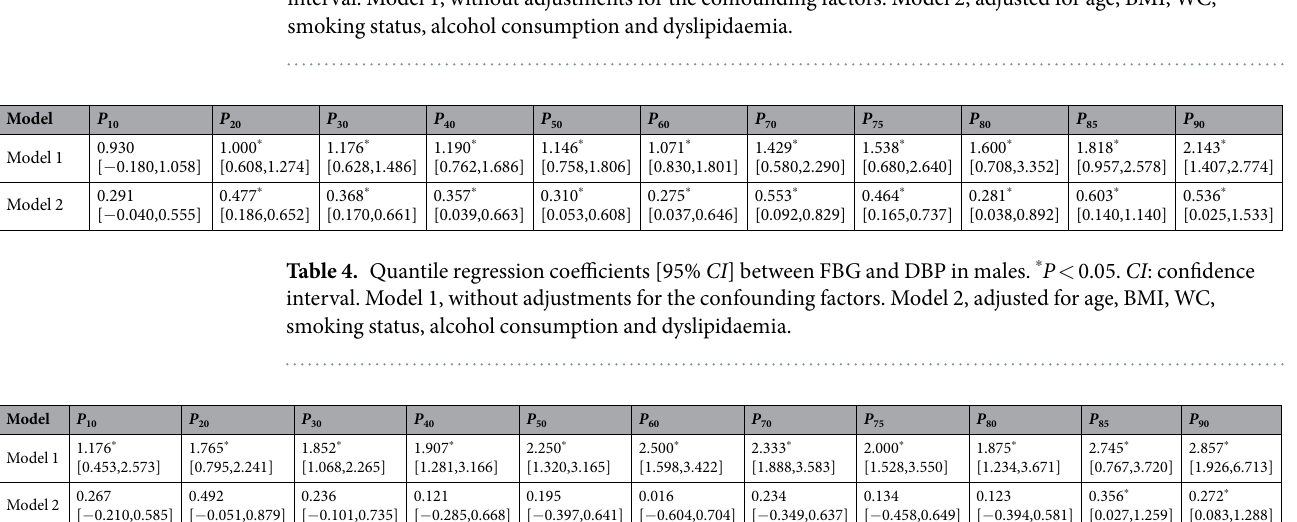
In addition, we found that the associations of BP with FBG were different in males and females; FBG was positively associated with both SBP and DBP in almost all quantiles in males, whereas FBG had positive associa- tions with only SBP in the high quantiles in females. The finding implied that the positive associations of BP with FBG were more notable in males than in females. There are several reasons for these associations. First, the risk of hypertension in females is lower than that in males 17 . Second, evidence has shown that the lower endogenous oestrogen levels found in males might be related to higher insulin resistance when compared with females 18 , which means that the same FBG levels in males and females may lead to different physiological effects due to dif- ferent levels of insulin resistance. Thus, the finding might suggest that control of one’s FBG level should be more emphasized and strengthened among males than females, except females with high SBP. The cut-off value for the definition of impaired fasting glycaemia (IFG) is still controversial at present; the American Diabetes Association (ADA) Expert Committee reduced the cut-off value of IFG to 5.6 mmol/L in 2003, while the World Health Organization (WHO) retained the previous cut-off value of IFG (6.1 mmol/L) 19 . Further, IFG has been shown as an independent risk factor for hypertension 20,21 ; however, whether the FBG level begin to become a potential risk factor for hypertension when it is close to 5.6 mmol/L is uncertain. Fortunately, our study showed that the positive associations of BP with FBG became stronger when FBG levels were close to 5.6 mmol/L, which implied that FBG level might begin to become a potential risk factor for hypertension when it was close to 5.6 mmol/L. A possible explanation is that the body may develop hyperinsulinaemia before FBG level reaches 6.1 mmol/L, and the presence of hyperinsulinaemia could directly contribute to an elevation in BP by increasing renal sodium retention 22 . Therefore, having awareness of controlling FBG levels when they